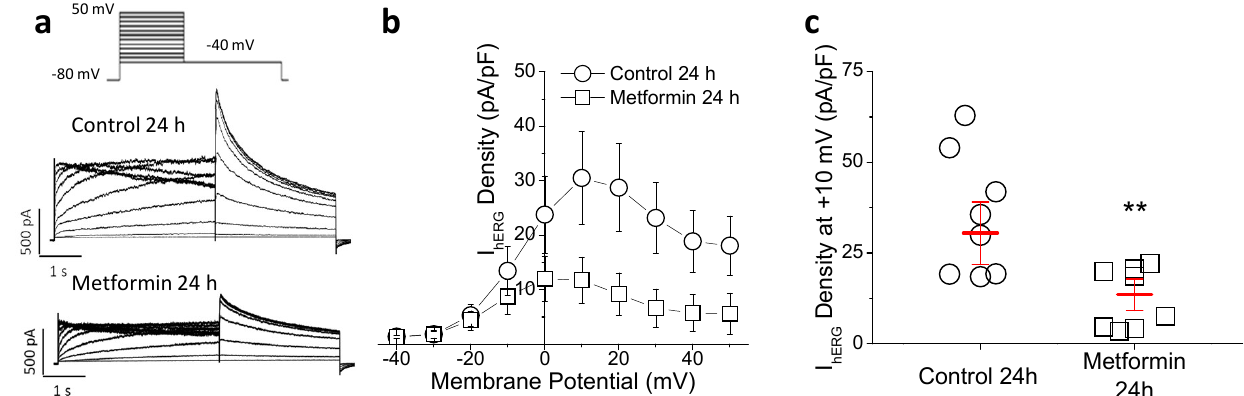
Figure 5. Incubation with metformin reduces I to in vitro. Cardiomyocytes isolated from control animals were incubated with 10 mM metformin or vehicle for 24 h. ( a ) Representative I to traces, ( b ) current density–voltage curve and ( c ) peak density at +50 mV (n = 8 control and 14 metformin). ( d ) Representative I Ca-L recordings, ( e ) current–voltage curve and ( f ) I Ca-L -density at +10 mV (n = 11 control and 4 metformin). Same protocols as in Figure 3. Points represent individual data with mean ± SEM (red marks), except for current–voltage curves, where mean ± SEM is shown. ** p < 0.01 compared to control.